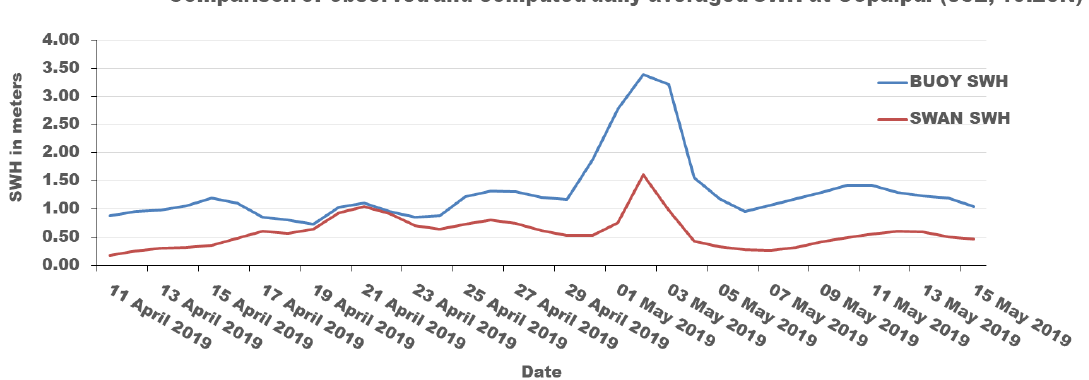
Figure 2. Comparison of observed and computed daily averaged SWH at Gopalpur (85°E, 19.25°N) during the cyclone FANI.